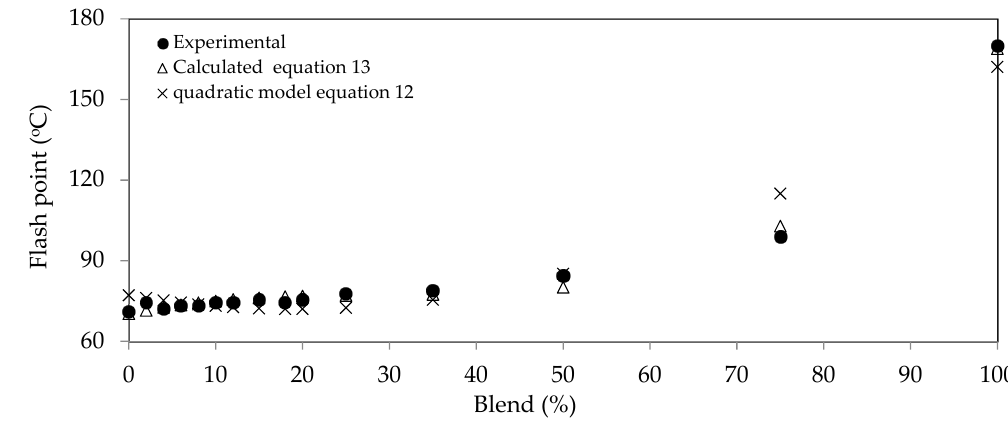
Figure 3. Flash point variation with biodiesel content.